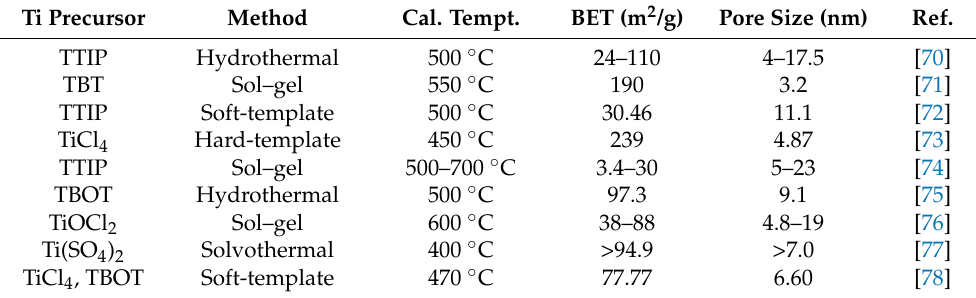
Table 4. Synthesized mesoporous TiO 2 by different Ti